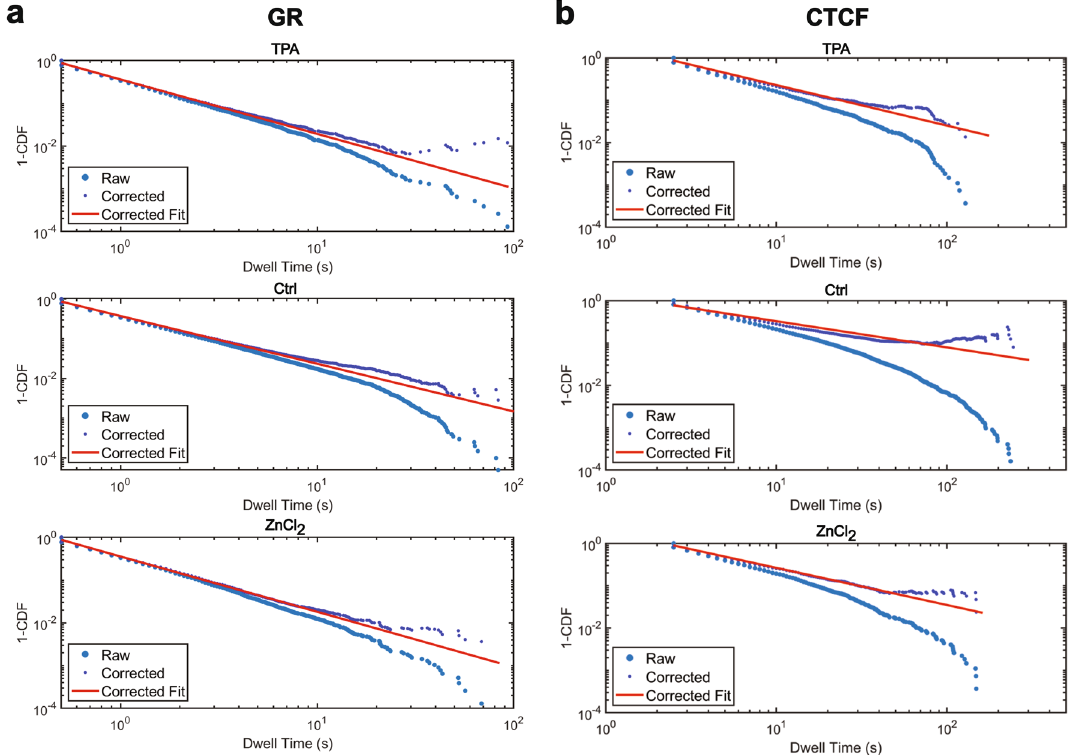
Figure 5. ( a ) Power law fits for HaloTag-GR for cells treated with 50 µM TPA (top), a media-only control (middle), or 30 µM ZnCl 2 (bottom). Raw survival distributions were corrected for photobleaching using the survival curves from untreated U-2 OS cells stably expressing H2B-HaloTag. ( b ) Same as in ( a ), but for HaloTag-CTCF.